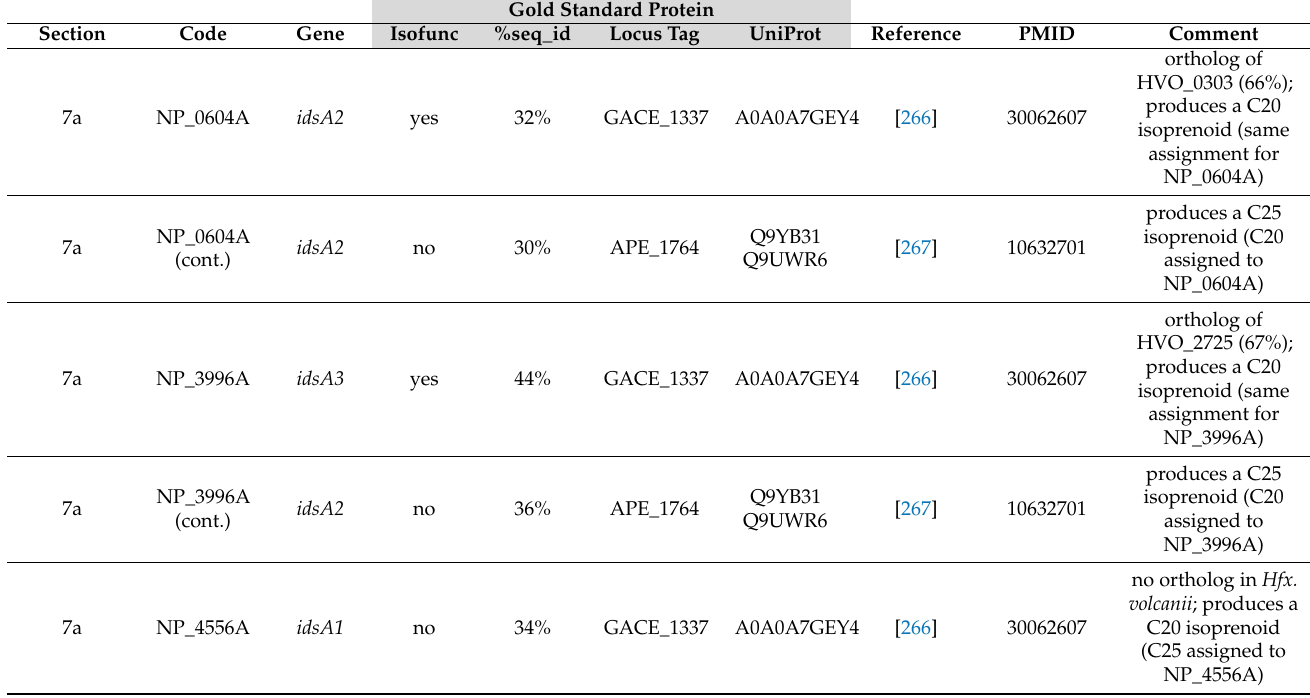
Table 7. Proteins with open annotation issues and their Gold Standard Protein homologs (Section 3.7). For a description of this table, see the legend to Table